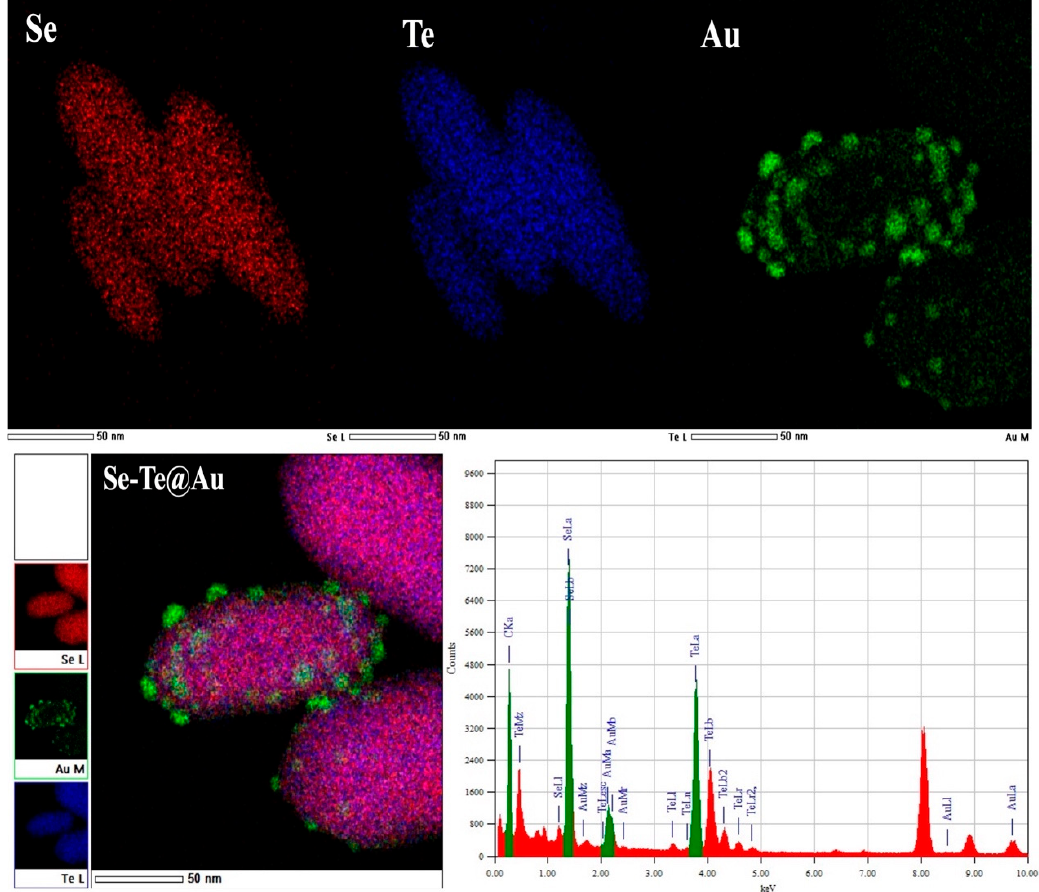
Figure 2. EDX spectral profile and HR-EDX mapping of the synthesized Se-Te@Au nanorods.